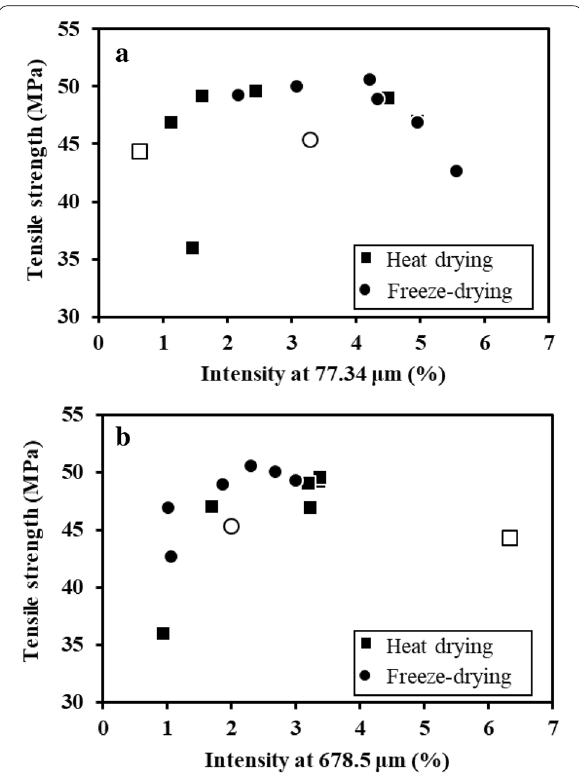
Fig. 9 The relationship between impact strength of WPC and intensity of the particle size distribution analysis at a 77.3 µm and b 678.5 µm. Open square, heat drying 0 min and open circle, freeze-drying 0